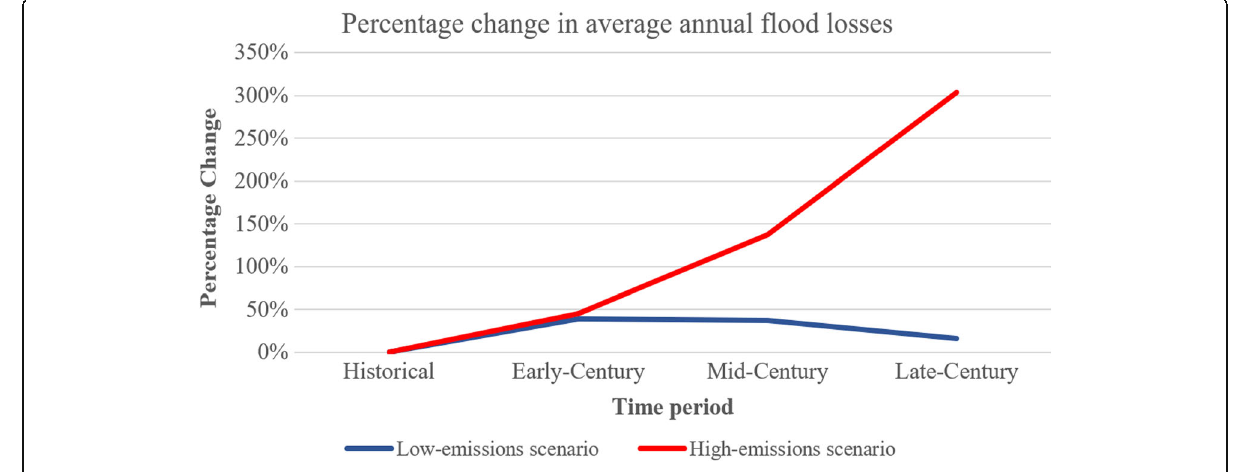
Fig. 5 Percentage change in average annual flood